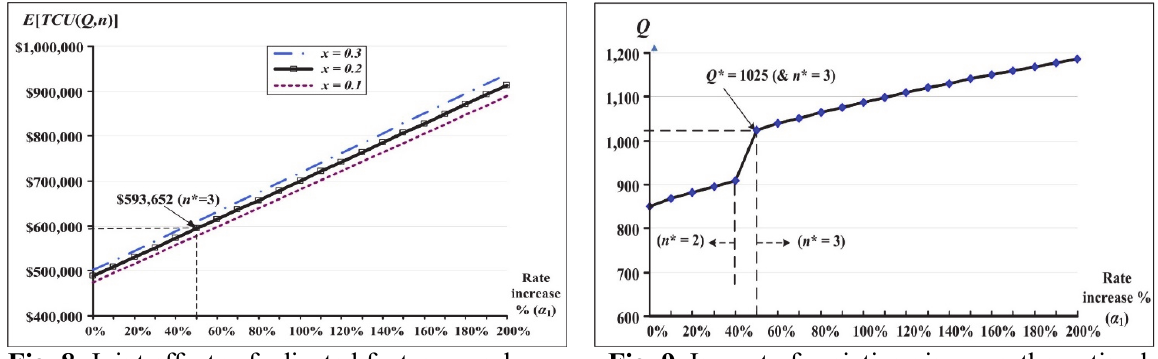
Fig. 8. Joint effects of adjusted factor α 1 and nonconforming rate x on E [ TCU ( Q , n )]